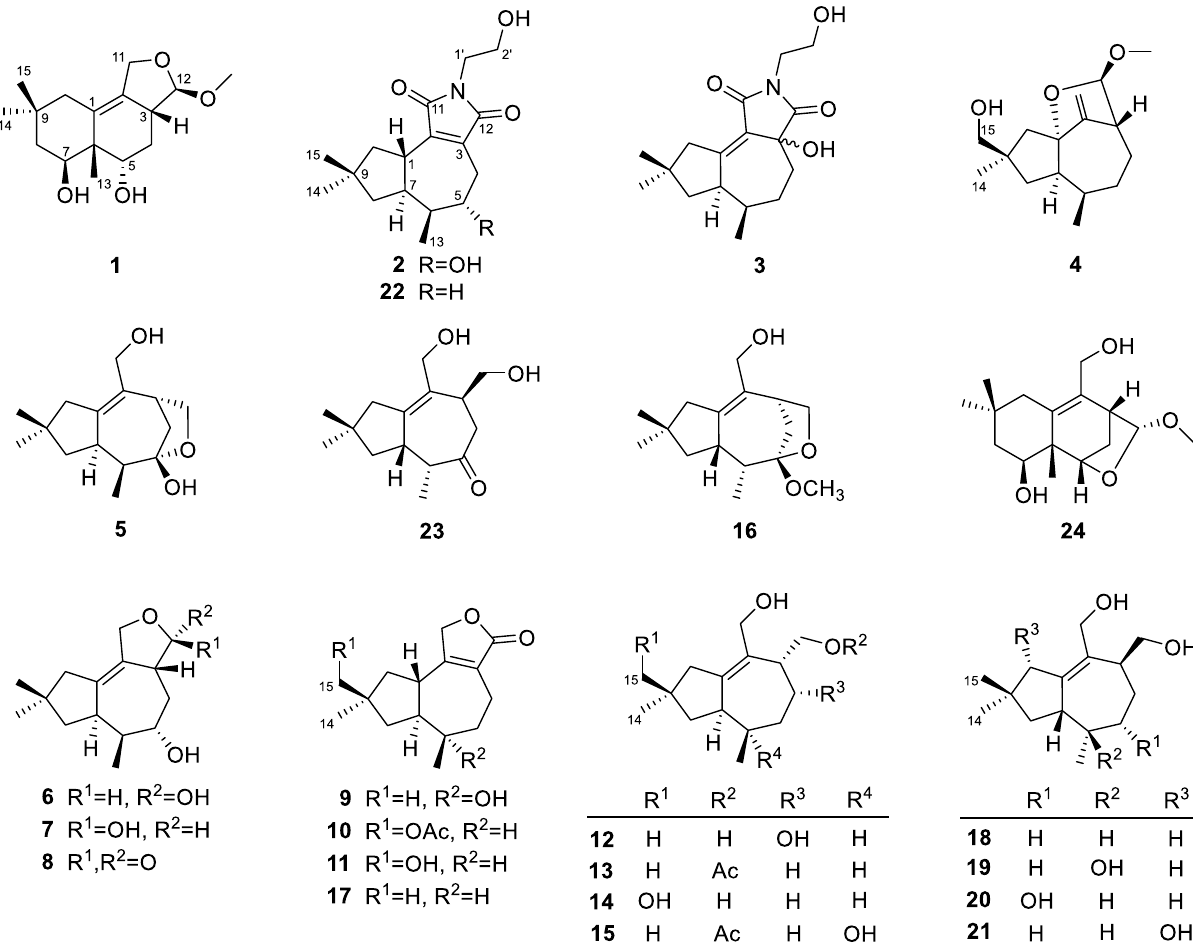
Fig. 1 Structures of compounds 1 –